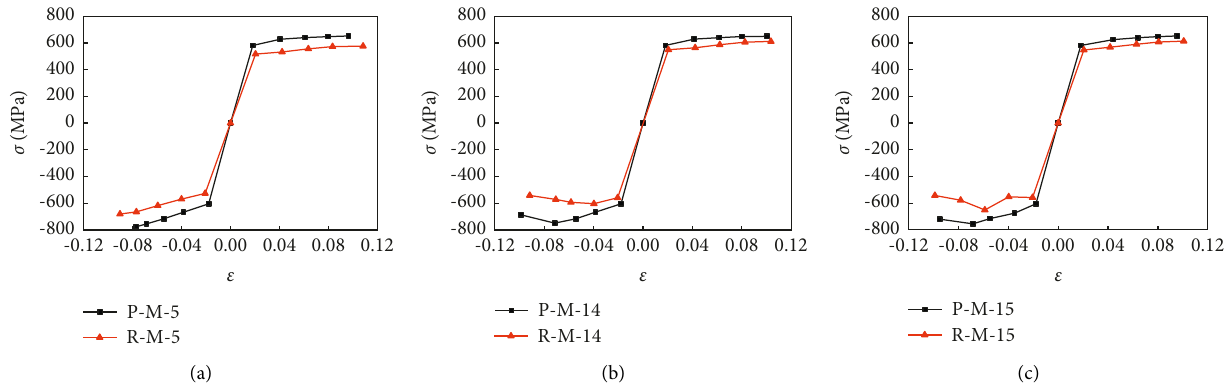
Figure 21: Skeleton curves of material specimens with different cross section shapes. (a) Specimens under the loading pattern NM19. (b) Specimens under the loading pattern NM20. (c) Specimens under the loading pattern NM21.